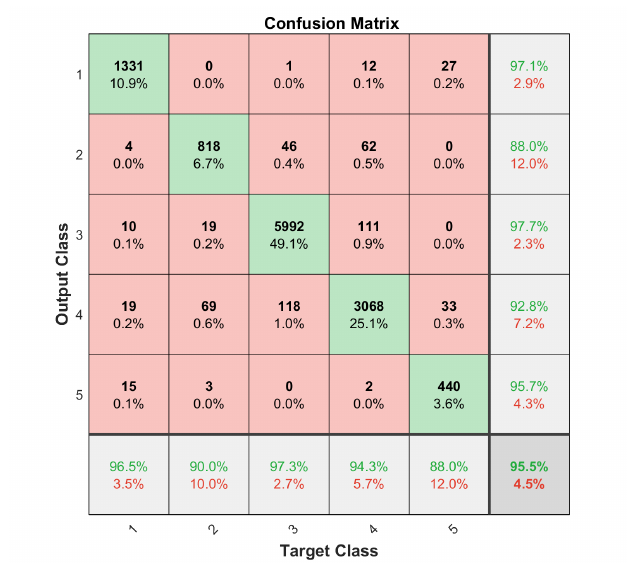
Figure 7. Classification results using the 35 selected miRNAs as features.